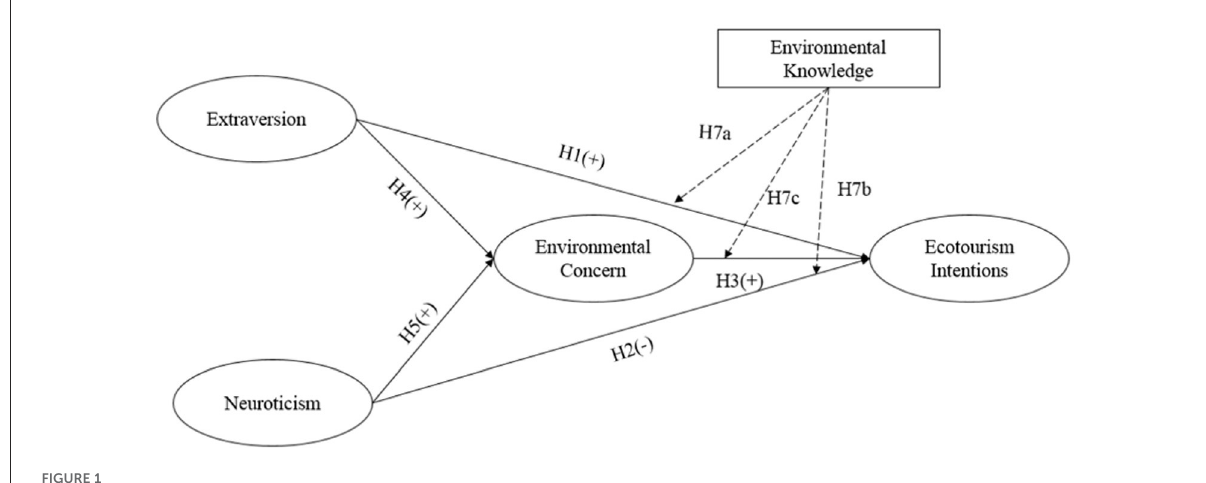
FIGURE1 Conceptual